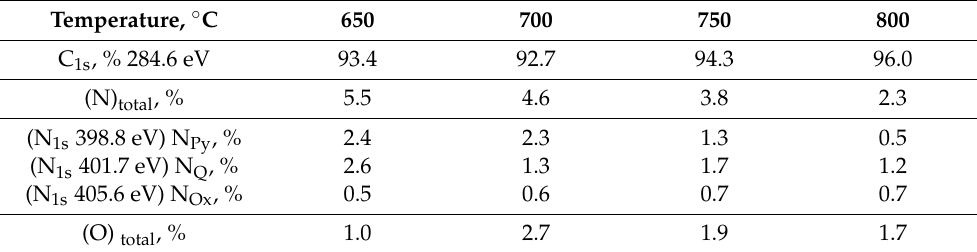
Table 5. Percentage of elements in N-CNT at different temperature (NH 3 content in reagent mixture of 50% vol.).